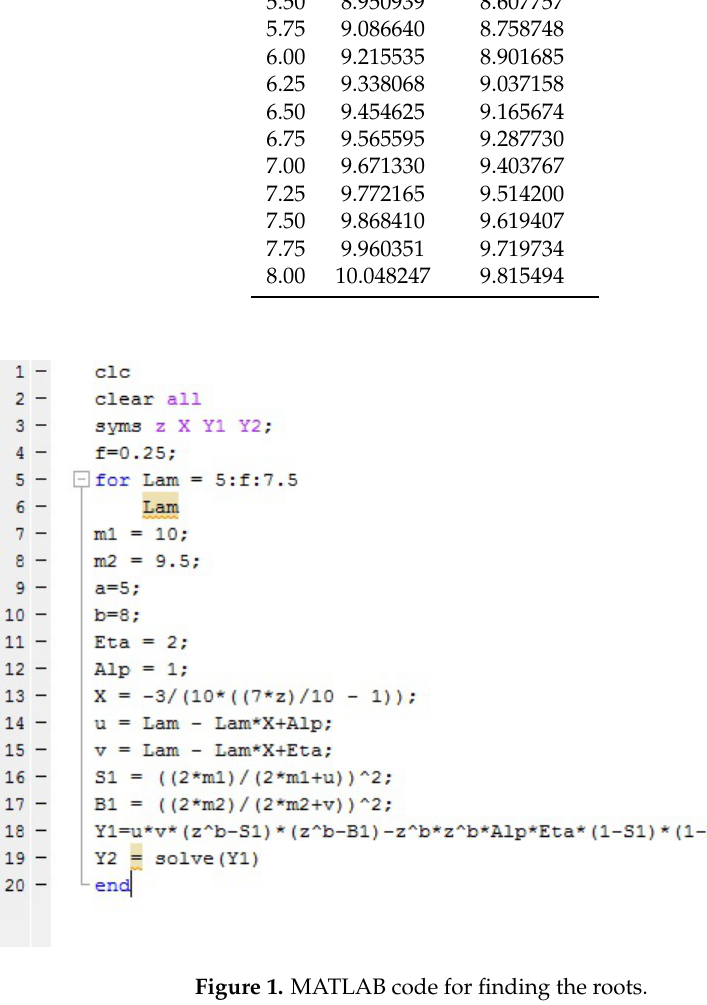
Figure 1. MATLAB code for finding the